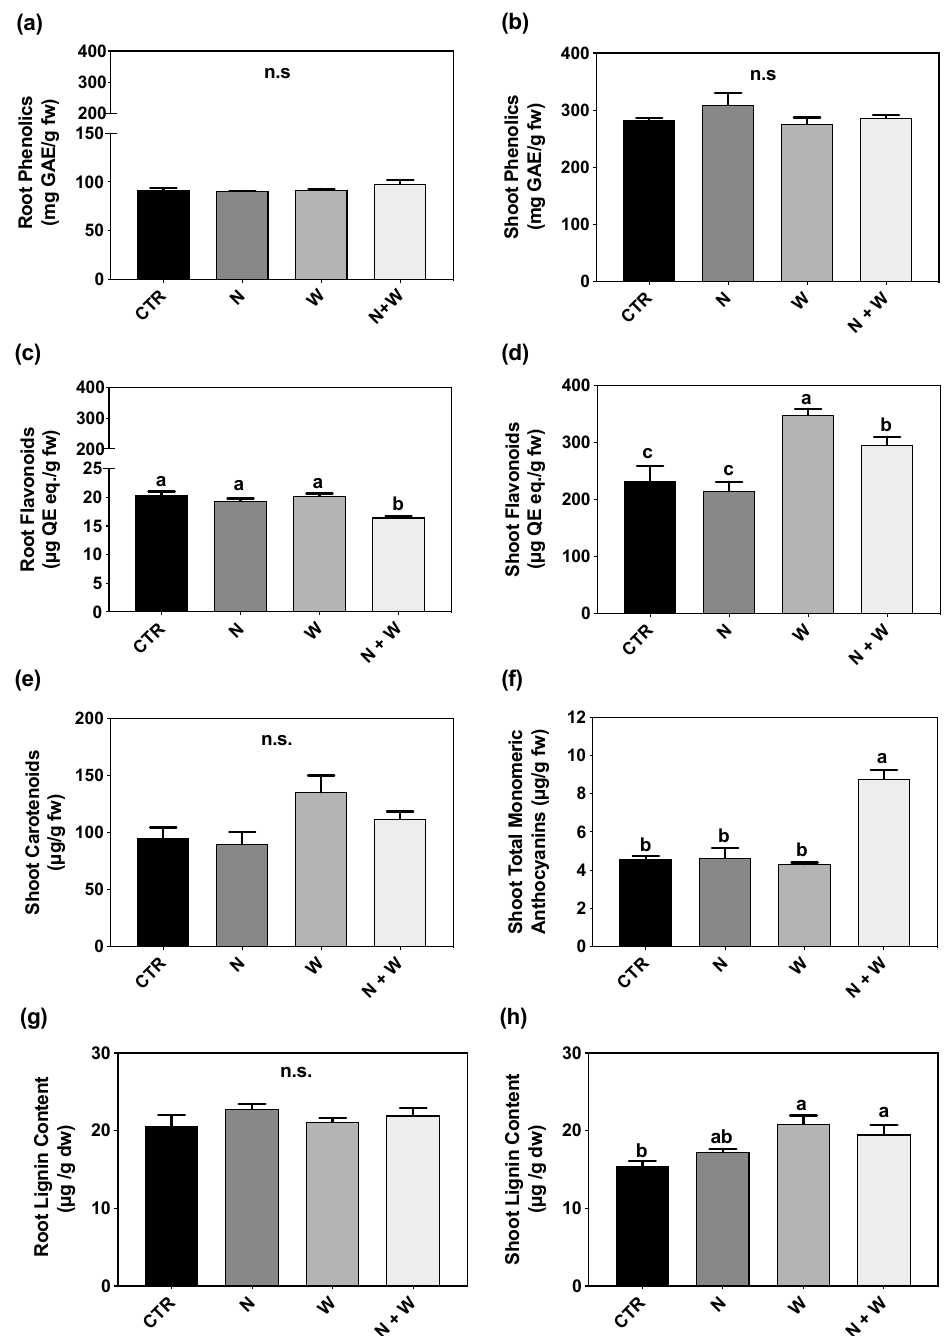
Figure 3. Total phenolics in roots ( a ) and shoots ( b ), total flavonoids in roots ( c ) and shoots ( d ), total monomeric anthocyanin in roots ( e ) and shoots ( f ), and lignin concentration in roots ( g ) and shoots ( h ) of tomato plants cv. Micro-Tom grown for 16 days under control (CTR; 10.5 mM N + 100% W), nitrogen deficit (N; 5.3 mM N + 100%W), water deficit (W; 10.5 mM N + 50% W) or combined nitrogen and water deficit (N + W; 5.3 mM N + 50% W). Data presented are mean ± SEM ( n = 3). Different letters above bars indicate significant differences and n.s. correspond to non-significant differences between treatments according to Tukey’s HSD test ( p = 0.05).